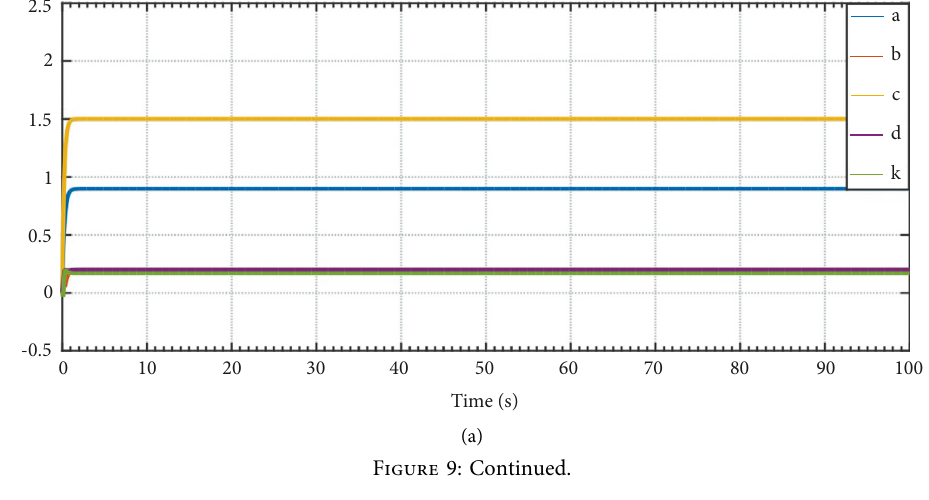
( 0 ) , y ( 0 ) � ( 2 , − 1 )] . (d) Anti- 3 3 ( 0 ) , y ( 0 ) � (− 3 , − 4 )] . (e), (f) Time history of the 4 4